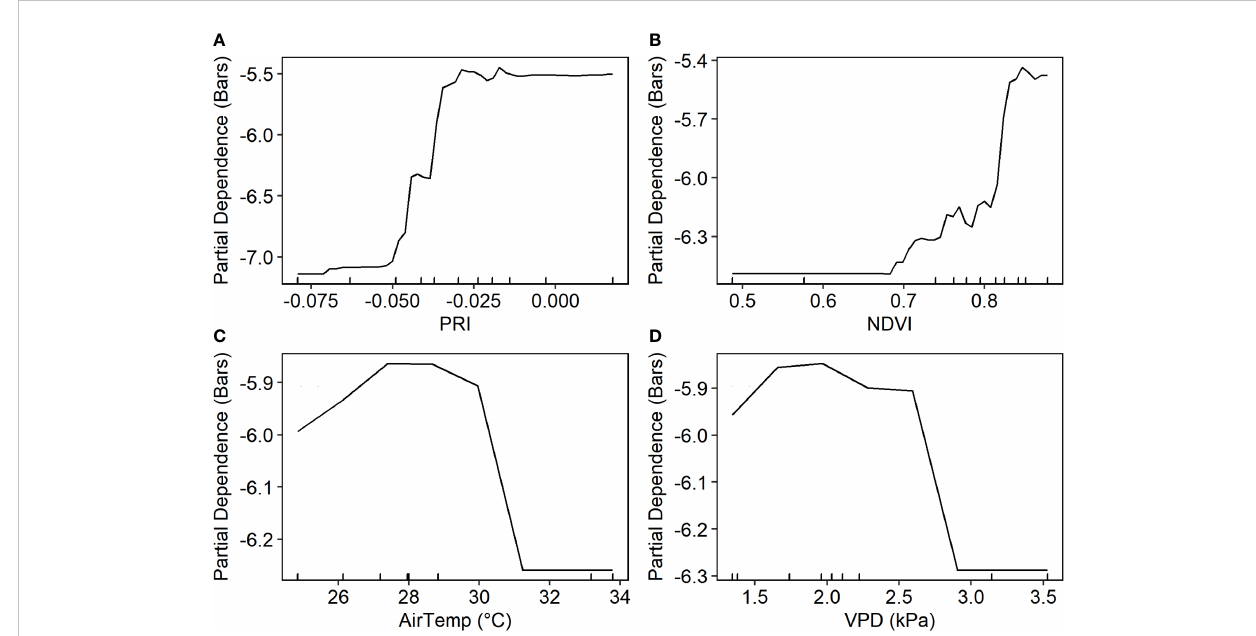
FIGURE 8 Partial dependence of stem water potential on four predictors based on the proximal sensor-based random forest